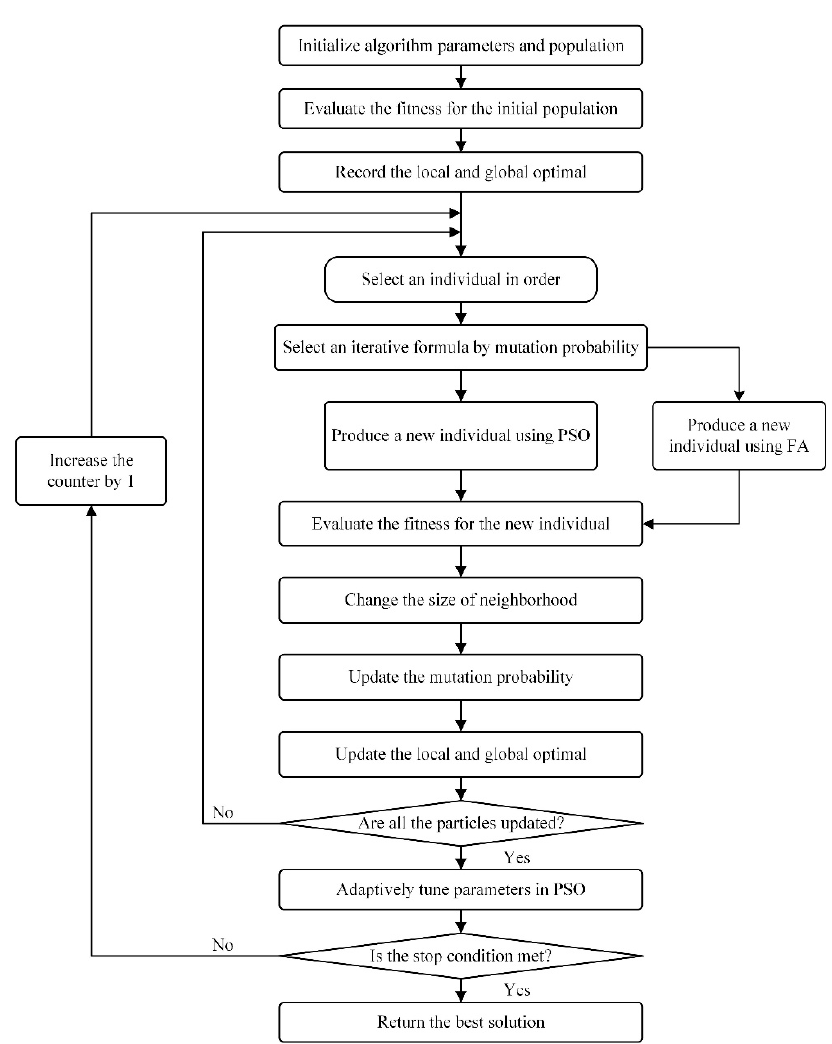
Figure 6. Standard block diagram of adaptive fuzzy particle swarm optimization (AFPSO).